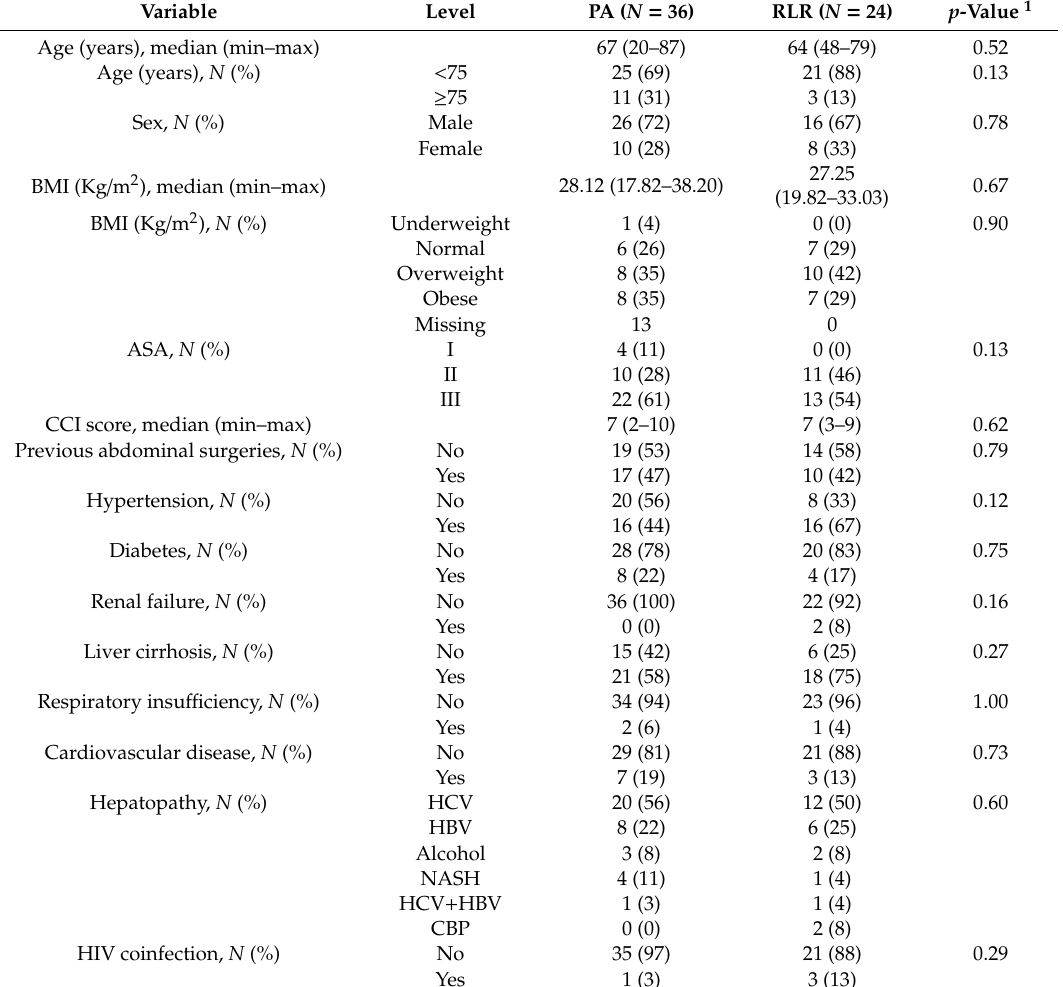
Table 1. Demographic and clinical characteristics ( N =